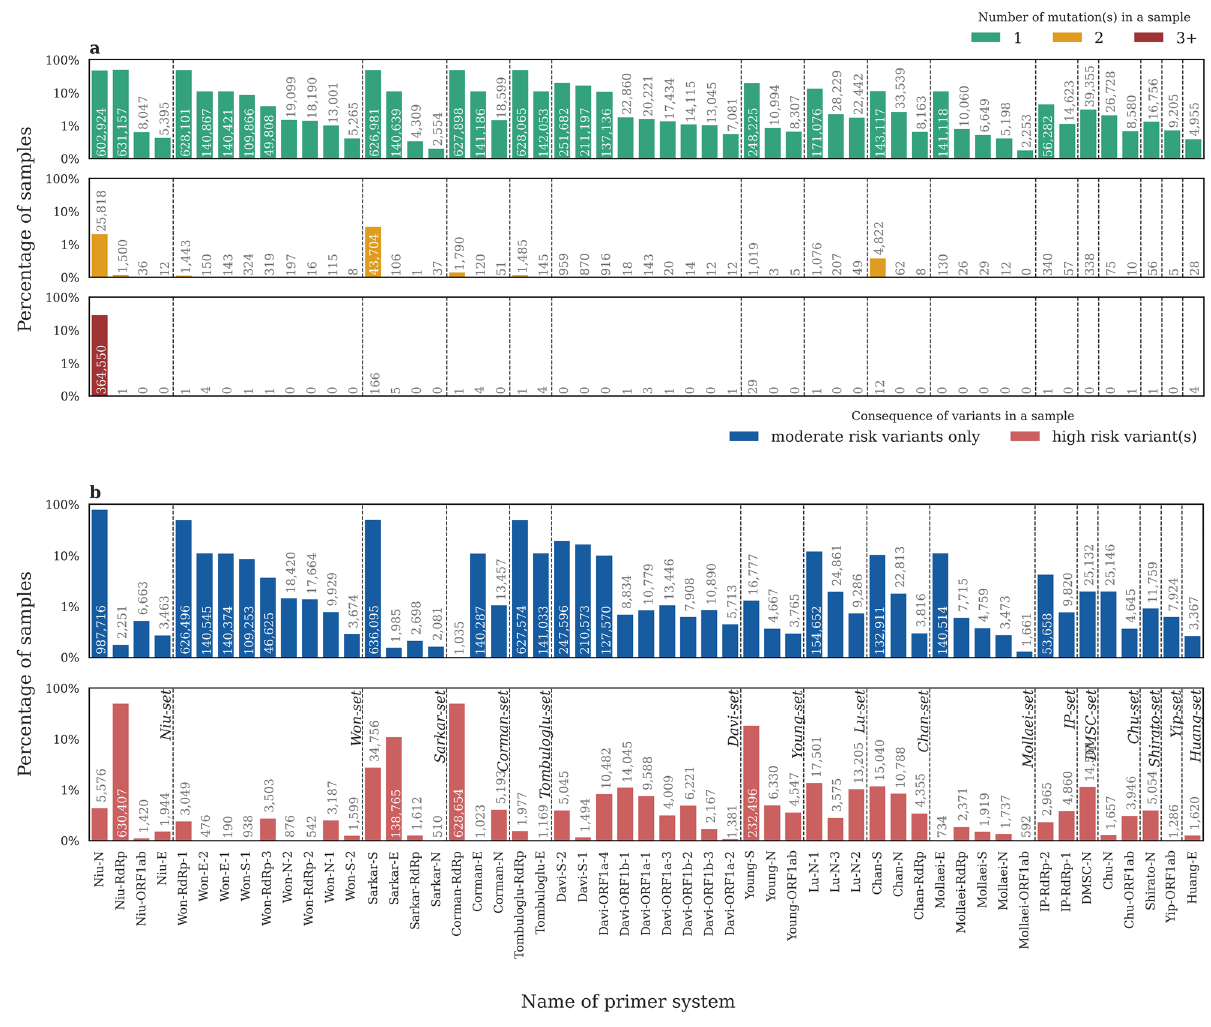
Figure 3. Number of mutations and their possible effect on PCR amplification. (For another version of the figure with linear vertical axes, see Supplementary Fig. 3. Supplementary Figs. 4–9 contain the same results separately for different variant strains). ( a ) The percentage and number of samples with one (green bars), two (yellow bars) and three or more (red bars) variants in the TRs of different primer systems. ( b ) The percentage and number of samples with variants in the TRs of different primer systems. Samples that contain a variant in at least one “high risk” position in the TRs of the given primer system are marked with red, other samples having only “moderate risk” mutations in the given TRs are presented in blue. For further details on mutation classification, see “Methods”. Primer system names are based on the nomenclature: [first author last name]- [target gene name]-[id, when multiple primer systems target the same gene]. Samples with no variants in the given TRs are not